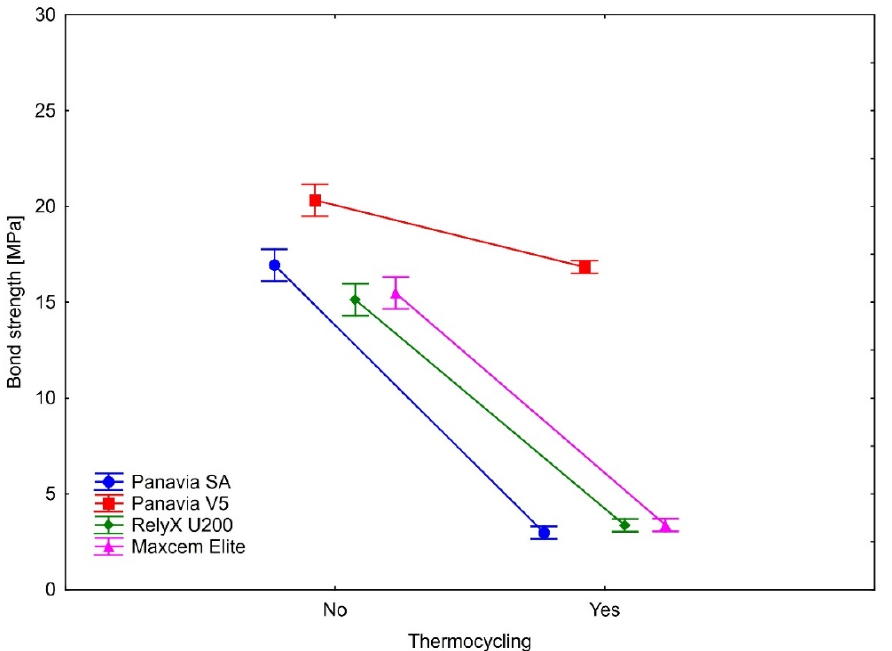
Figure 5. The effect of thermocycling on luting cements bond strength to IPS Empress CAD. Vertical bars denote 0.95 confidence intervals around the mean values.